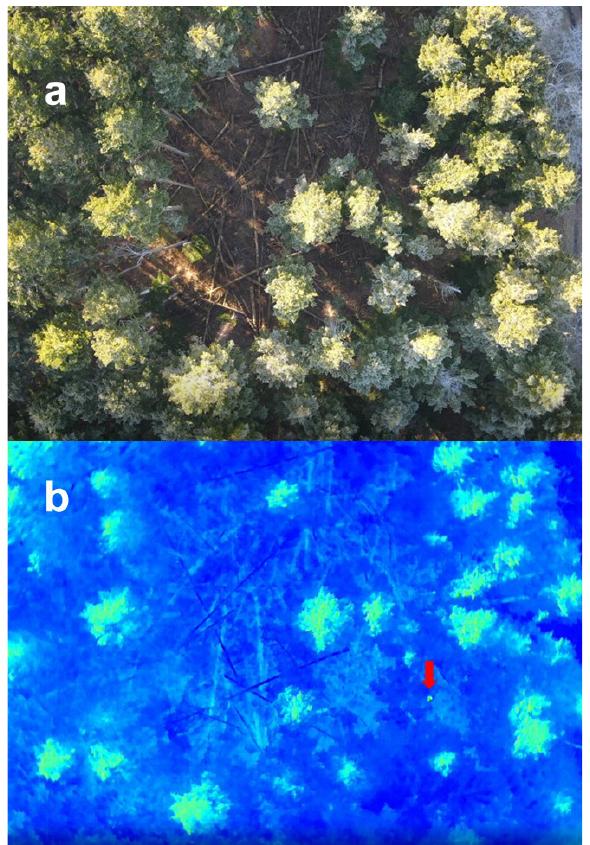
Figure 8 . Screen shots of movie files acquired by M2EA; RGB image (a) of a coniferous stand and thermal image of the same area (b). Colors are shown as relative temperatures, with higher temperatures from blue to red. Red arrow indicates sika deer individual.